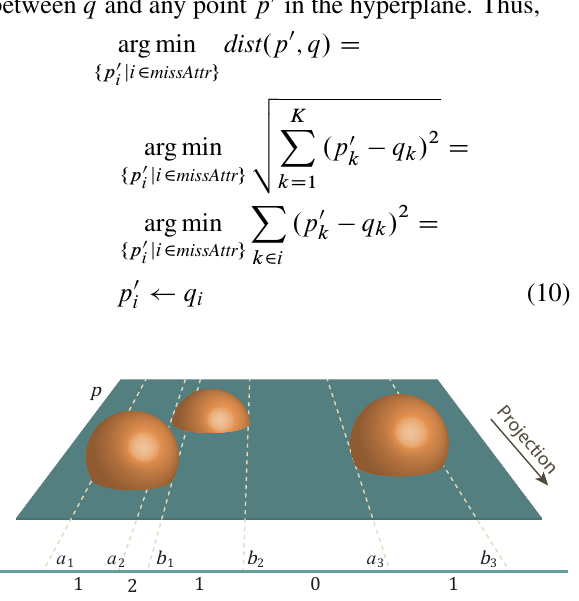
Fig. 4 Predicting multi-dimensional missing